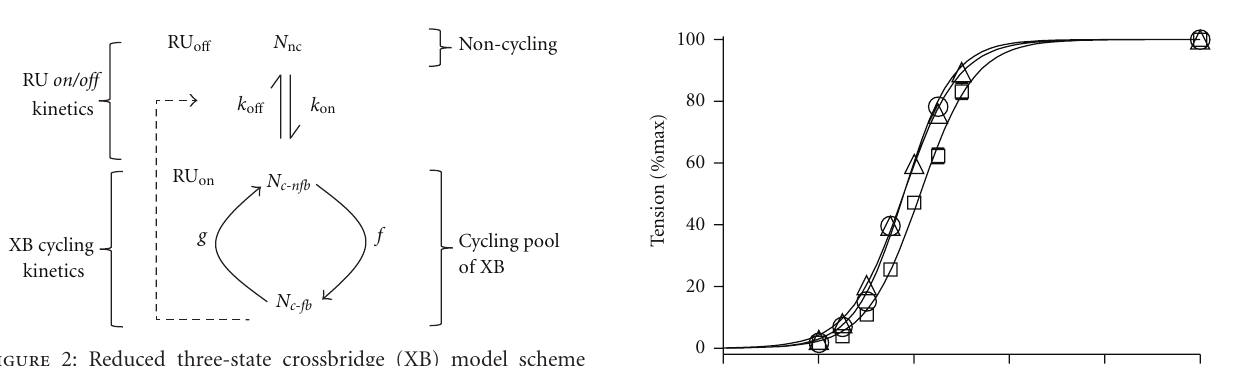
Figure 2: Reduced three-state crossbridge (XB) model scheme depicting regulatory unit (RU; Tm-Tn) kinetics and XB cycling kinetics. This scheme is adapted from Campbell [36]. k on and k o ff , represent the RU on/o ff rates and are functions of Ca 2+ bound Figure 4: Comparison of normalized pCa-tension relationships to cTnC. Once turned on by the binding Ca 2+ , RU permits the in detergent-skinned fibers reconstituted with cTnC WT , cTnC L29Q , transition of XB from the non-cycling ( N nc ) pool to the cycling or cTnC G159D . Isometric steady-state tensions elicited by each pool of XB. The cycling pool of XB includes two states of XB: fiber in various pCa solutions were normalized with its respective cycling non-force-bearing ( N c -nfb ) and cycling force-bearing ( N c -fb ). value in pCa 4.3 solution. The normalized tensions were plotted The transition between non-cycling and cycling pools is mainly against pCa to construct the pCa-tension relationship. The Hill regulated by k on /k o ff kinetics of RU. The influence of the force- equation was fitted to the normalized pCa-tension relationships bearing XB on the RU on/o ff kinetics is represented by the feedback ) and the Hill to estimate myofilament Ca 2+ sensitivity (pCa 50 arrow (dashed line). f and g represent the rate constants governing and n H values are shown in Figures coe ffi cient ( n H ). pCa 50 forward transition, N c -nfb → N c -fb , and backward transition, N c -fb → 5(a) and 5(b), respectively. The curves presented here are Hill N c -nfb , respectively. fits to pCa-tension relationships in cTnC WT ( (cid:7) ), cTnC L29Q ( (cid:2) ), and cTnC G159D ( (cid:3) ) fibers, respectively. Values are expressed as mean ± SEM. Number of fibers tested in each group is as follows: 2 cTnC WT , n = 15; cTnC L29Q , n = 10; cTnC G159D , n =